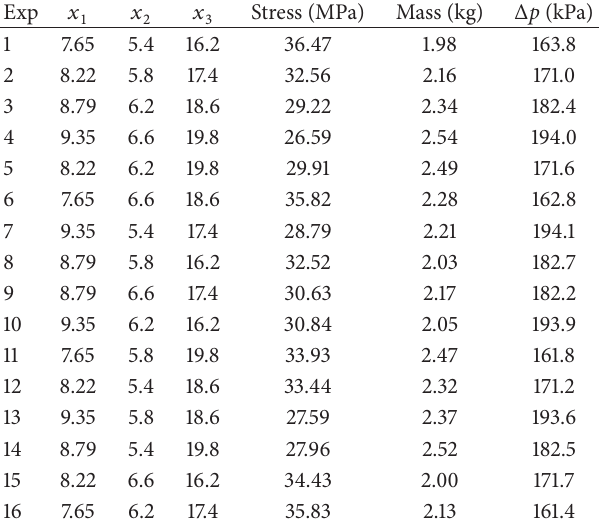
Table 3: Layout of the L16 orthogonal array based on the design of experiments and the responses obtained by the full numerical simulations.